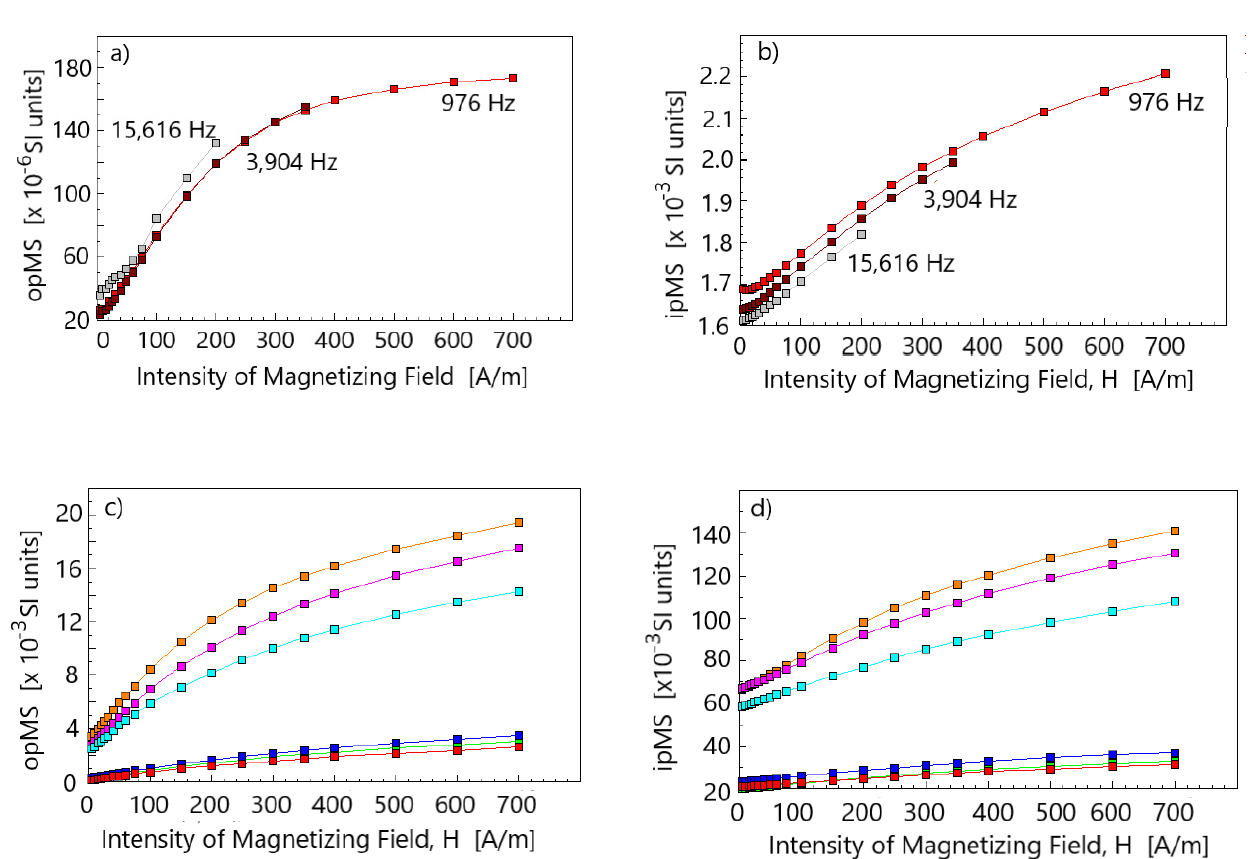
Figure 7. Relationships between opMS or ipMS and the magnetizing field and frequency in a speci- men of high-Ti titanomagnetite ( a , b ) and relationships between opMS or ipMS and the magnetizing field in several specimens of rocks with pyrrhotite ( c , d ). Adapted from [1]. The anisotropic properties of opMS in titanomagnetite, which possesses shape anisotropy, were investigated by Hrouda et al. [29]). It was found that the maximum opMS and ipMS are parallel to the longest dimension of the MD particle, whereas the minimum susceptibilities are parallel to the shortest dimension (Figure 5c). Therefore, the opAMS is conformable to the particle shape. In pyrrhotite and hematite, the maximum opMS and ipMS are parallel to the basal plane, whereas the minimum opMS and ipMS are parallel to the c-axis